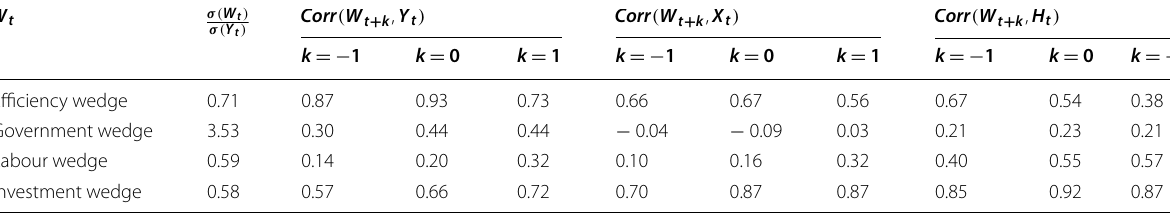
Table 7 Robustness: Wedge properties for ν = 0.5 (1980Q1–2016Q3)